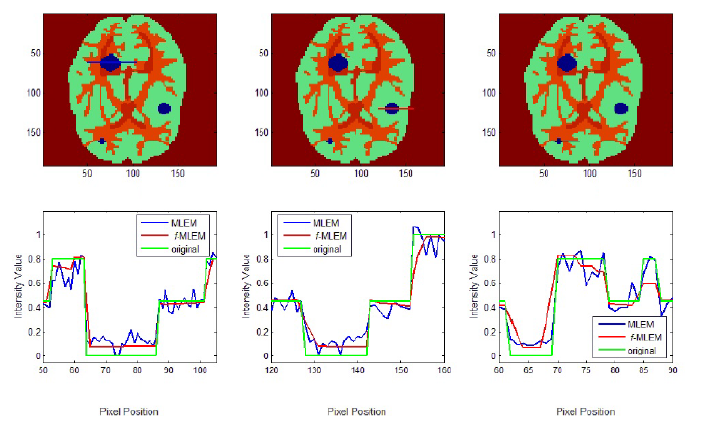
Figure 8. 1D Line profile of two reconstruction algorithms across different RIOs.